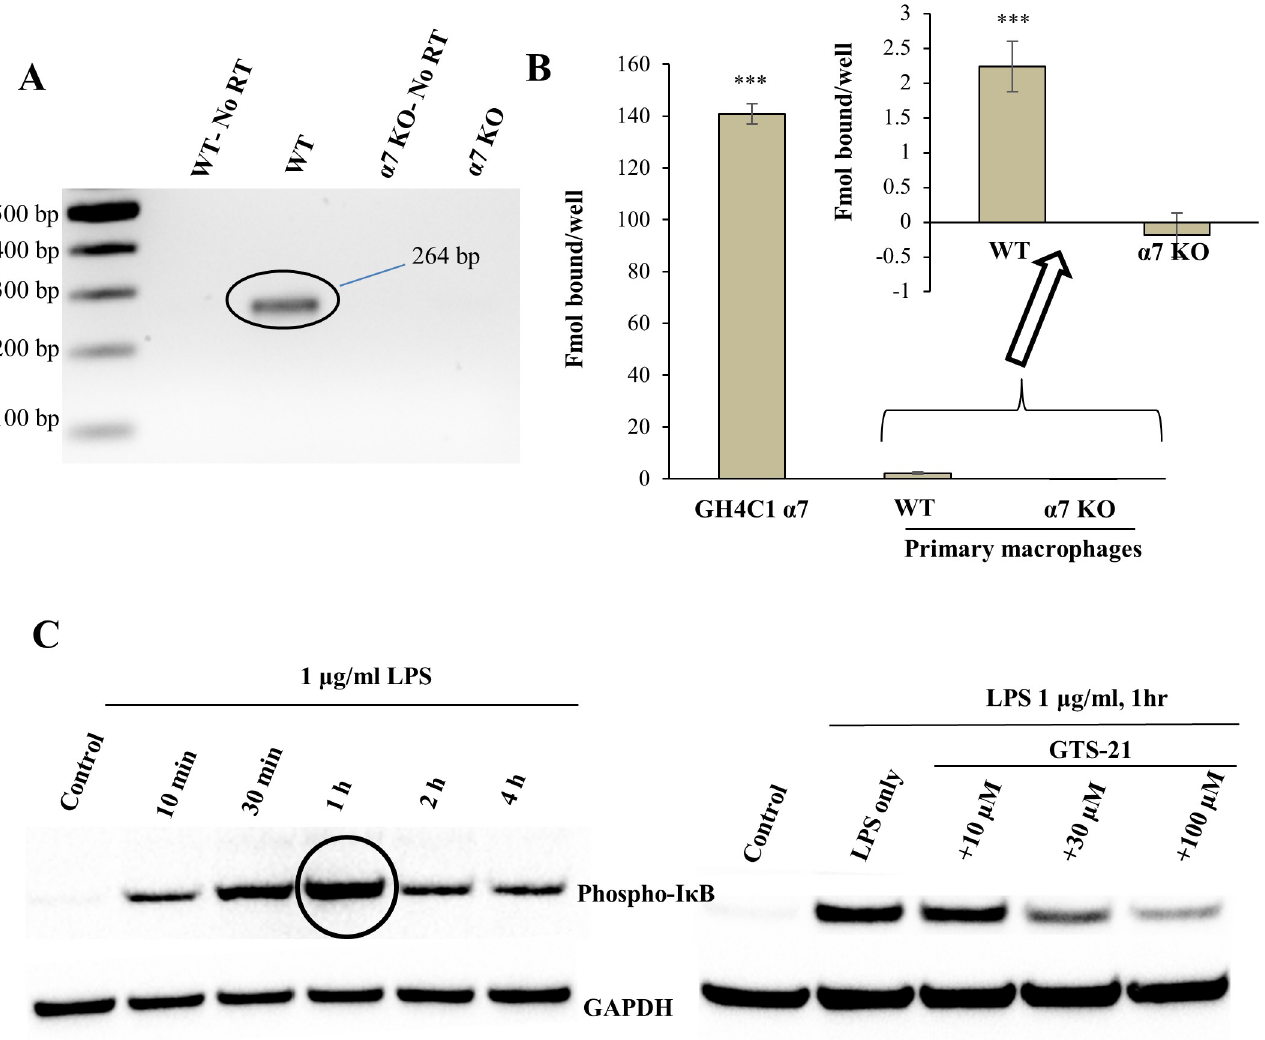
Fig 2. Confirmation of α 7 nAChR surface expression on mouse macrophages. (A) PCR analysis showing a band of 264 bp size confirming the presence of α 7 nAChR mRNA in macrophages isolated from WT but not α 7 nAChR knockout mice. The 100 base pair ladder was from New England Biolabs. No RT: No reverse transcriptase control. (B) 125 I- α BGT binding data comparing α 7 nAChR expression on macrophages isolated from WT and α 7 nAChR knockout murine model. α 7 nAChR transfected GH4C1 cells were used as a positive control. Macrophages from WT mouse showed a small but significant α BGT specific binding site (detected with 100 nM 125 I- α BGT). Bars in the figure represent specific binding. ��� P < 0.0001 compared to α 7 nAChR knockout mouse macrophages. (C) Left: Western blot data suggested LPS induced maximal pI κ B levels in WT mouse macrophages at 1 h (circled). Right: GTS-21 attenuated LPS-stimulated pI κ B levels in mouse macrophages in a dose-dependent manner. GAPDH was the loading control.